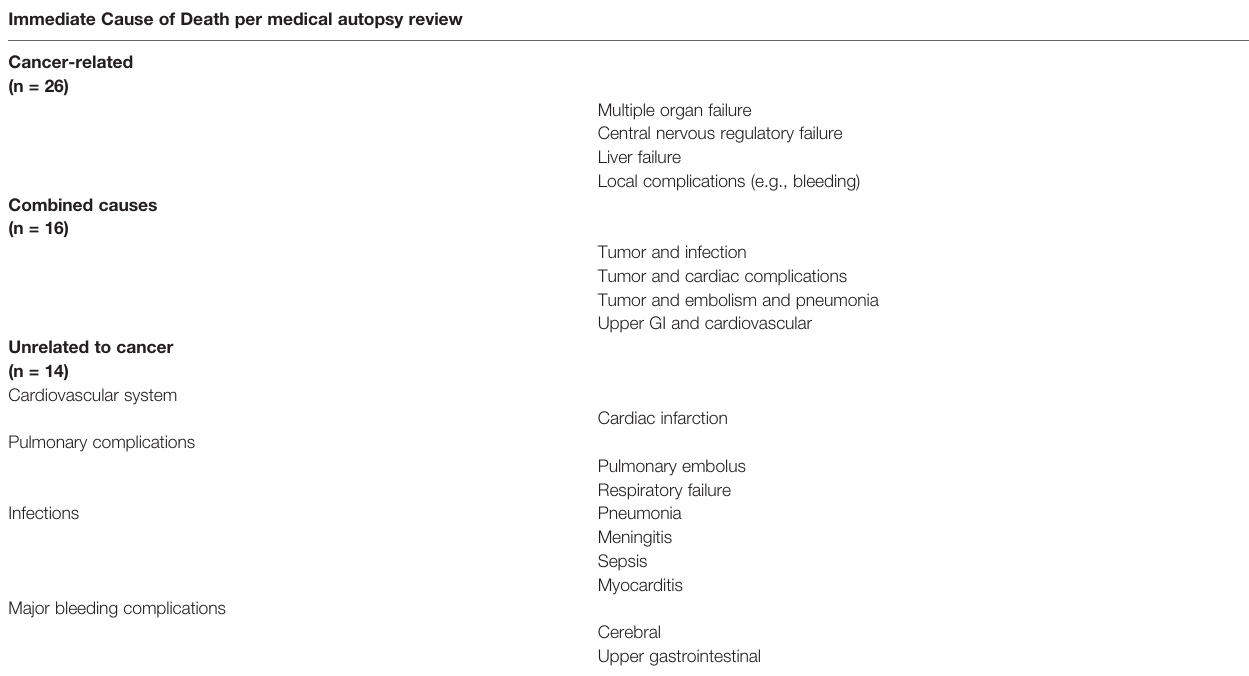
TABLE 2 | Shown are the immediate causes of death as con fi rmed by